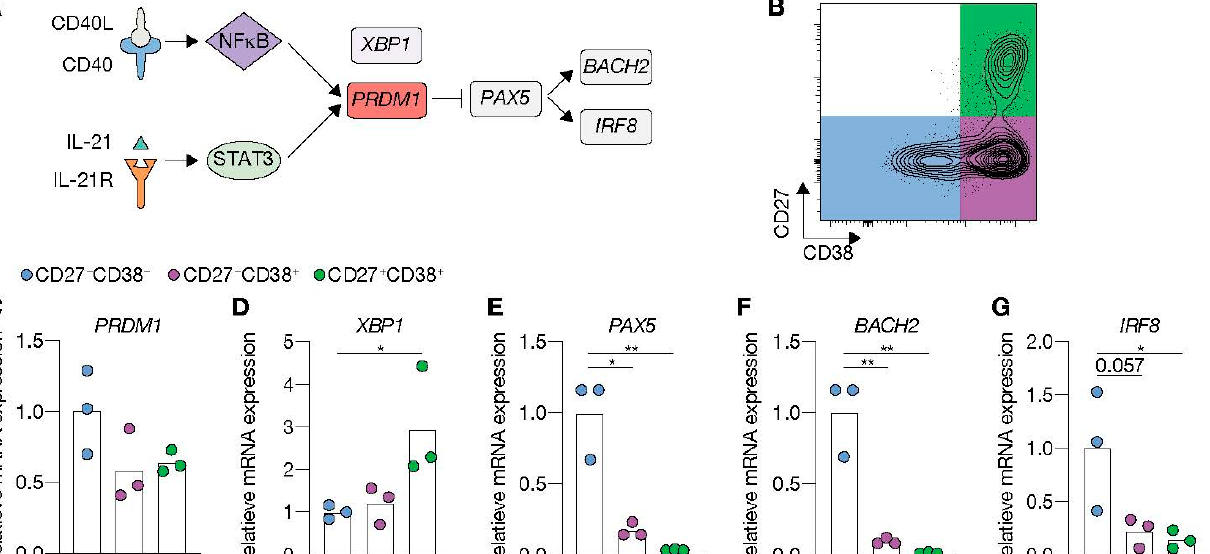
frequency ( C ) and number ( D ) of CD27 + CD38 + cells were analyzed 11 days after initial only, or initial + secondary culture. ( E ) Representative plots of CD138 expression within the CD27 + CD28 + ASC population. ( F ) The frequencies of CD138 + plasma cells were determined 11 days after initial only or initial + secondary culture. ( G , H ) Cumulative secretion of IgM ( G ) and IgG ( H ) measured in culture supernatants 11 days after initial only or 5 days after initial + secondary culture. Each data point represents the mean of an individual experiment (n = 3) with triplicate measurements. Mean values are repre- sented as bars. p -values were calculated using multiple t-tests. * P ≤ 0.05, ** P ≤ 0.01, *** P ≤ 0.001, **** P ≤ 0.0001.